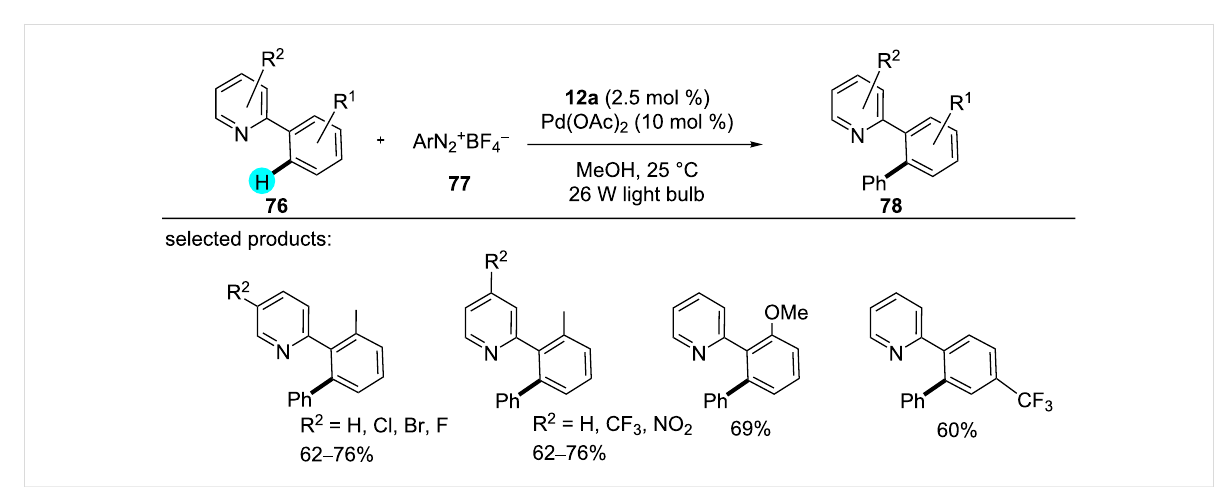
Scheme 10: Aryl-substituted arenes prepared by inorganic photoredox catalysis using 12a